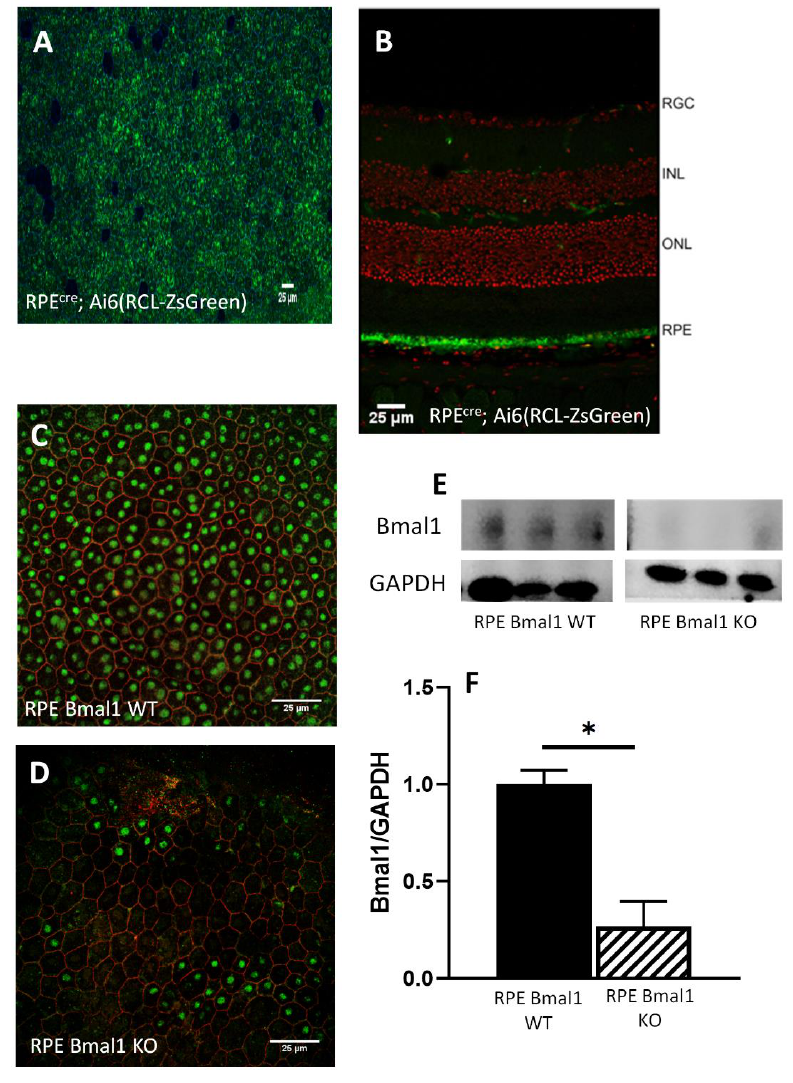
Figure 1. Validation of RPE Bmal1 KO mouse model. RPE cells of RPE cre ; Ai6(RCL-ZsGreen) mice were visualized en face as a flat mount; there was about a 95.8% expression of cre recombinase activity (green) in RPE cells that were demarcated with zonula occludens ( A ; blue). Transverse retinal sections from RPE cre ; Ai6(RCL-ZsGreen) showed expression of cre recombinase (green) primarily in the RPE cell layer with some unexpected cre recombinase expression in the outer and inner plexiform layer ( B ); the nuclear layers of the retina were stained with propidium iodide (red). Representative microphotographs displaying Bmal1 immunoreactivity (green) in RPE Bmal1 KO and RPE Bmal1 WT mice as prepared in an RPE flat mount with RPE cells demarcated with zonula occludens (red; C , D ). Bmal1 immunoreactivity in RPE cells of RPE Bmal1 KO mice ( D ) was decreased (~70%) compared to expression in RPE Bmal1 WT mice ( C ). To determine the total level Bmal1 protein in the RPE, we measured Bmal1 and GAPDH in total RPE protein extracts by Western blot ( E , F ). Bmal1 protein was significantly reduced (about 70%) in RPE Bmal1 KO when compared to RPE Bmal1 WT mice (F; * = p < 0.05, unpaired t -test, n = 3 mice/group). Data are expressed as mean ± SEM.